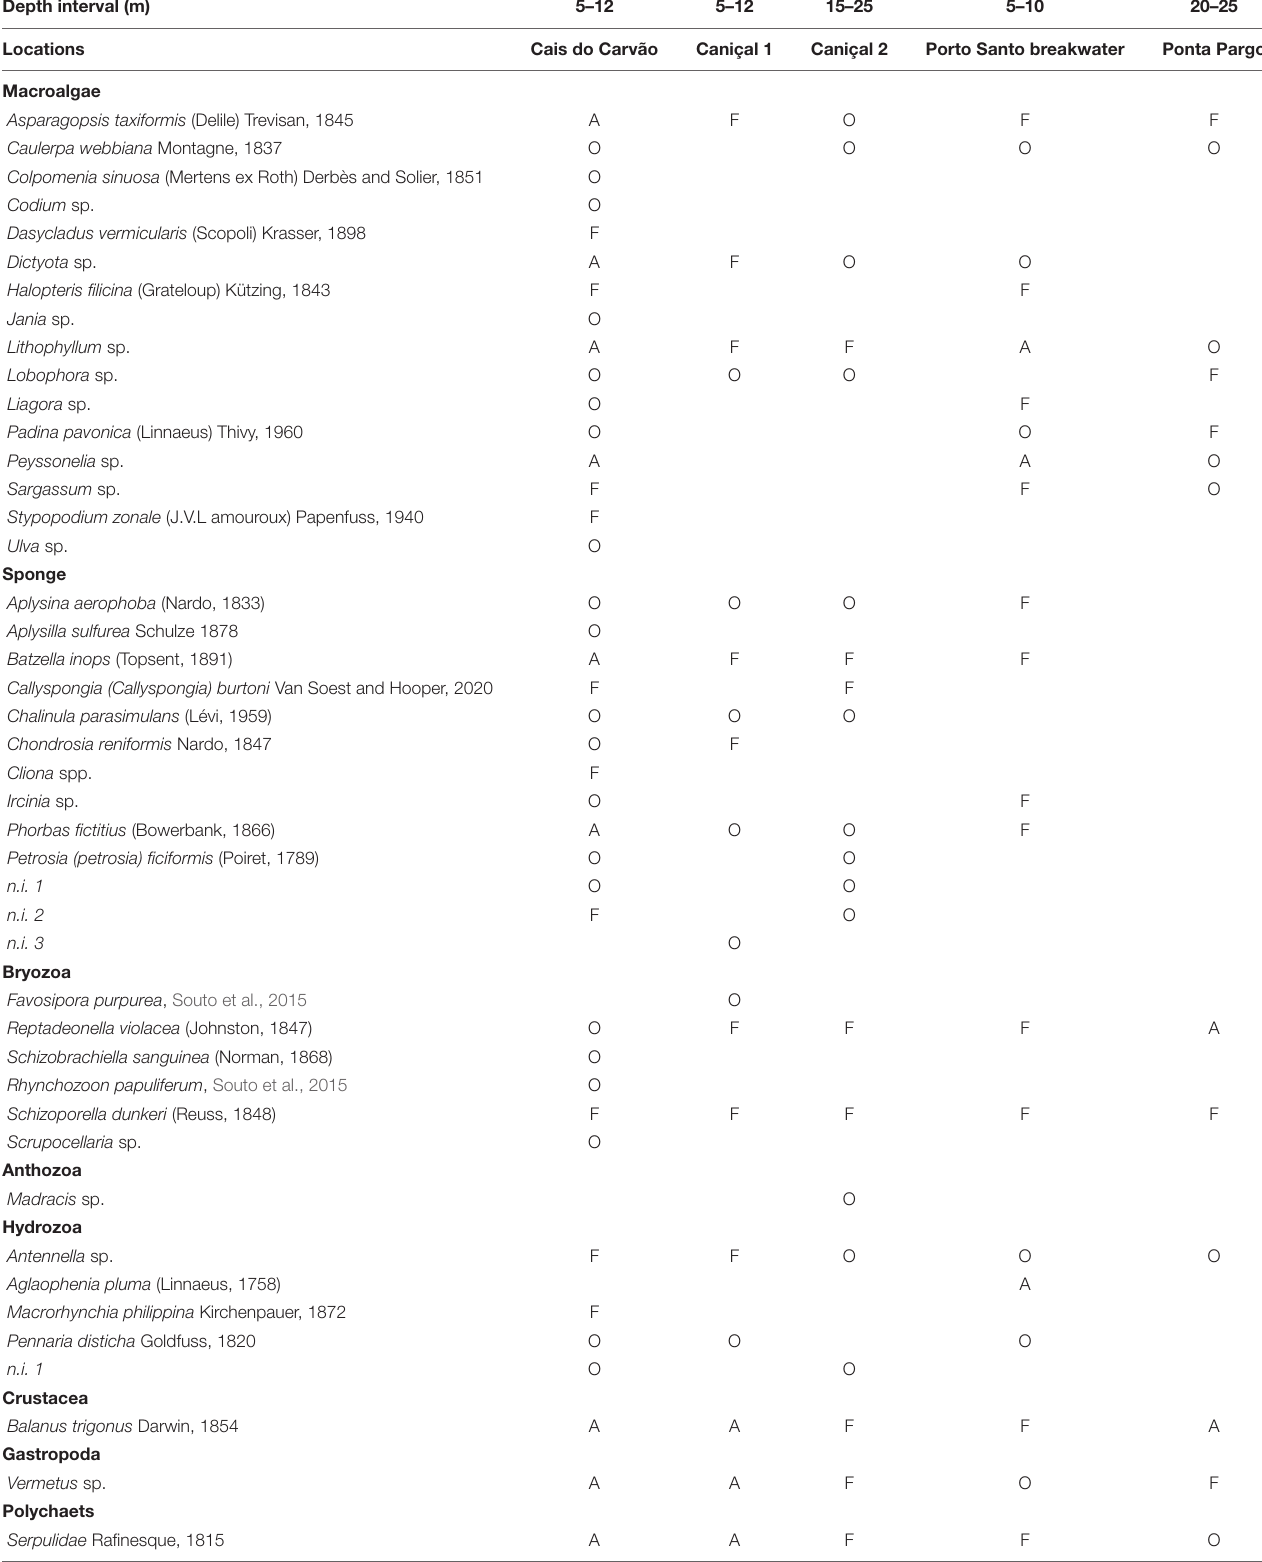
TABLE 1 | List of the main sessile macrobenthic fauna and flora associated to the five locations where Sphaerechinus granularis was observed in Madeira archipelago. Depth interval